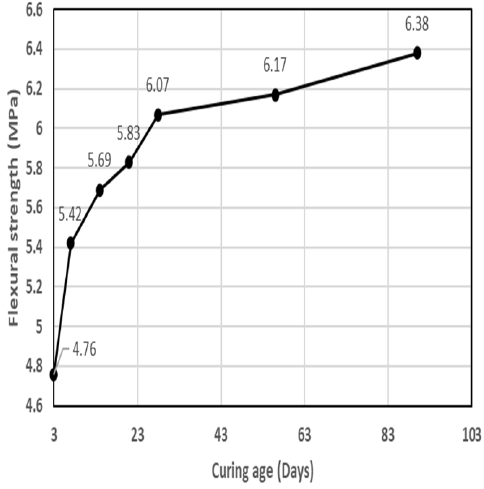
Figure 17. Variation in flexural strength with curing period of SRMB.